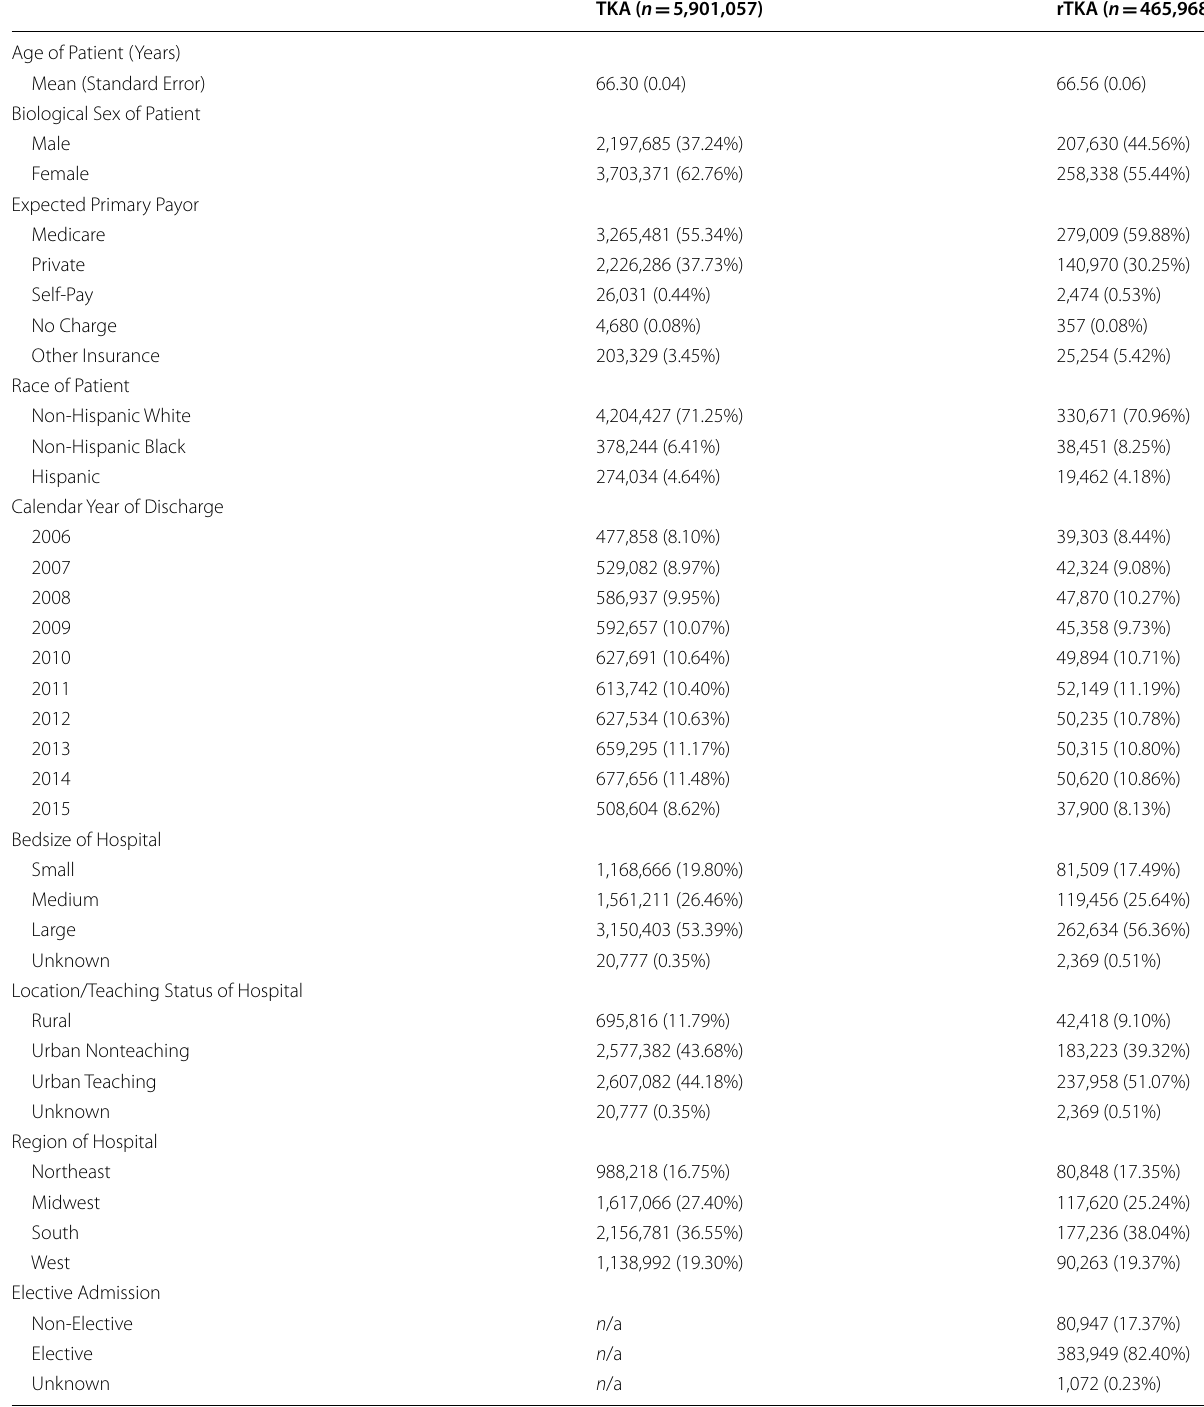
Table 1 Comprehensive list of demographic data collected from the NIS database of patients undergoing TKA and rTKA from 2006 to the third quarter of